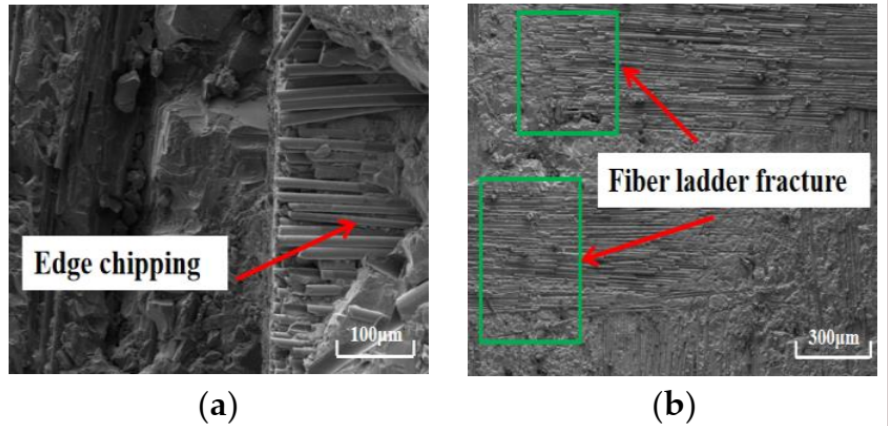
Figure 12. Morphology of the surface machined with PCD tool in cryogenic machining: ( a ) sidewall ( × 180); ( b ) bottom ( ×